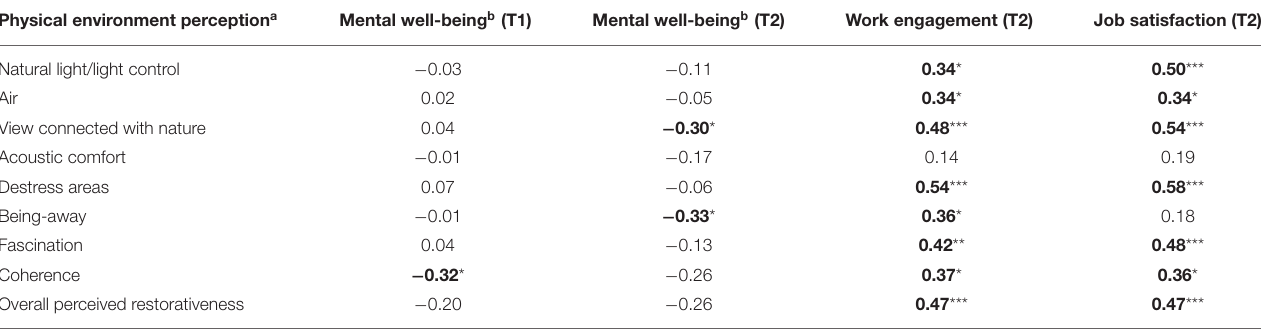
TABLE 3 | Pearson’s correlation coefficients between the study variables about quality and restorativeness of the workplace and psychological well-being outcomes. Physical environment perception a Mental well-being b (T1) Mental well-being b (T2) Work engagement (T2) Natural light/light